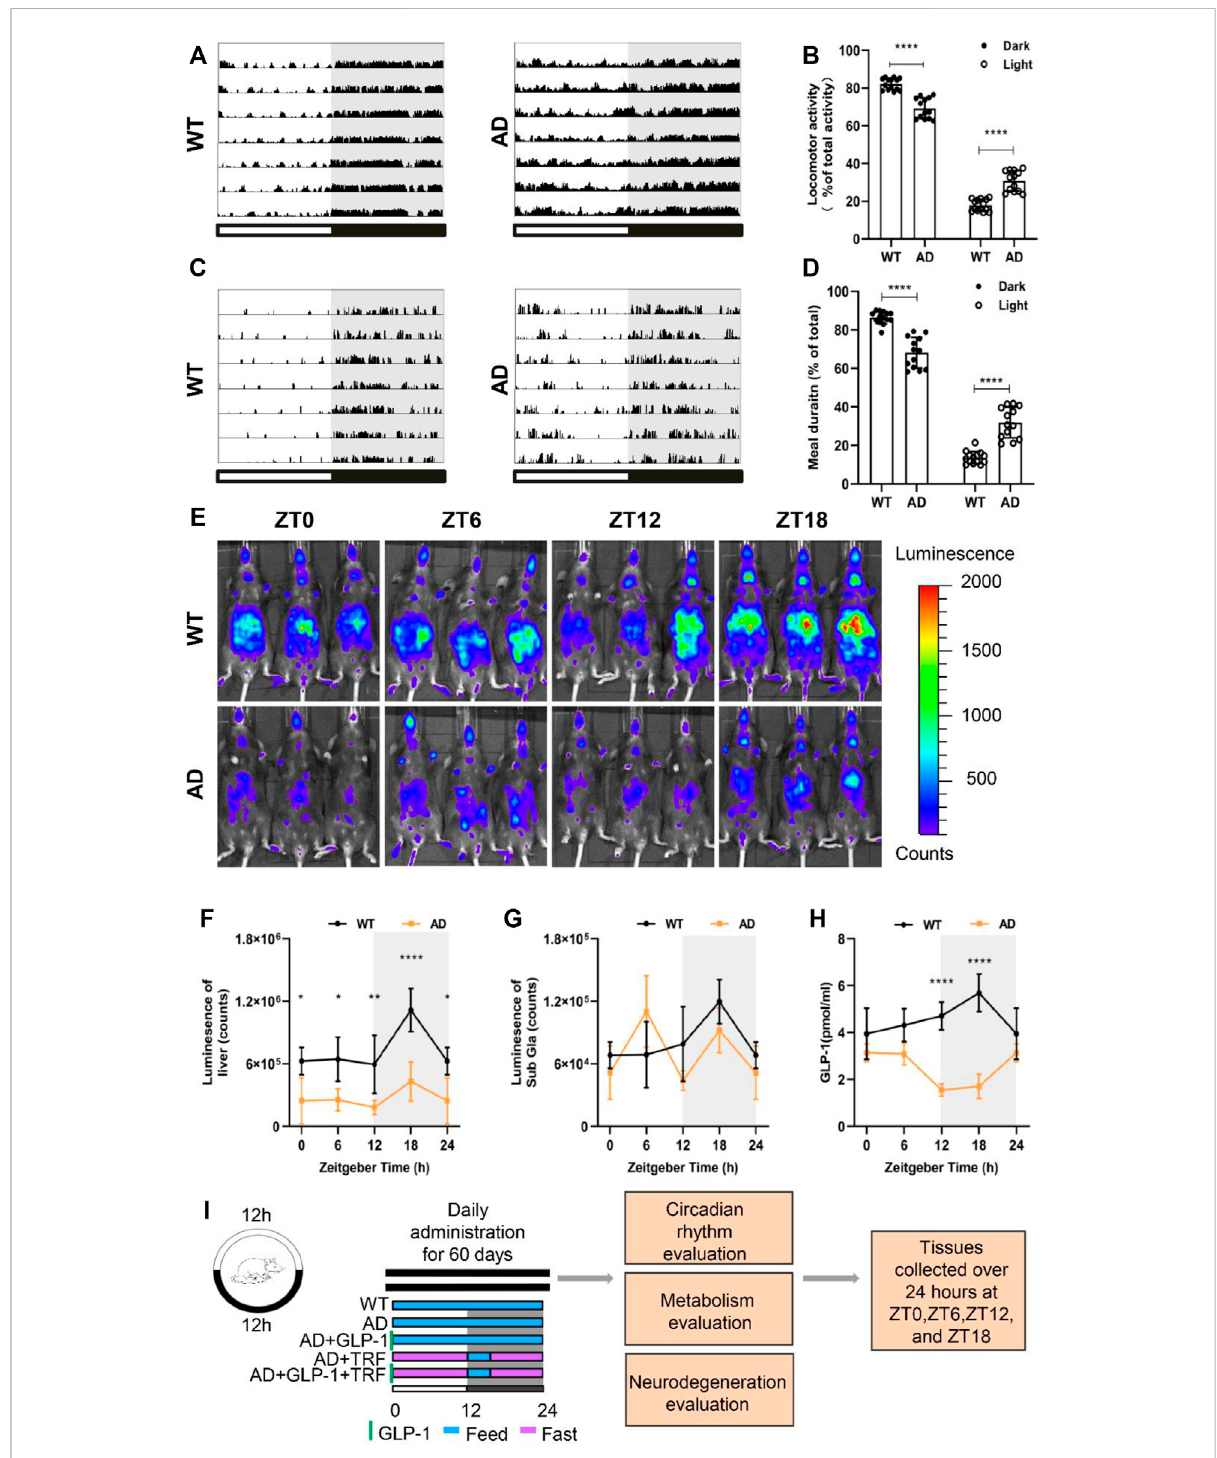
FIGURE 1 Alzheimer ’ s disease mice exhibit circadian rhythm disturbances. (A) Representative locomotor activity records of 5 × FAD mice (AD) and